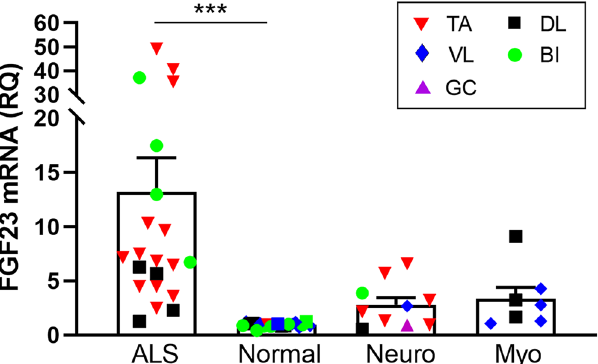
Figure 1. FGF23 mRNA levels are increased in ALS muscle tissue. FGF23 mRNA levels were assessed in human muscle samples by qPCR using GAPDH as an internal housekeeping control. Disease samples were expressed as a fold-change (mean ± SEM) compared to normal control tissue (set at 1). *** P = 0.0001. BI, biceps brachii; DL, deltoid; GC, gastrocnemius; Myo, myopathy disease control; neuro, neuropathy disease control, TA, tibialis anterior; VL, vastus